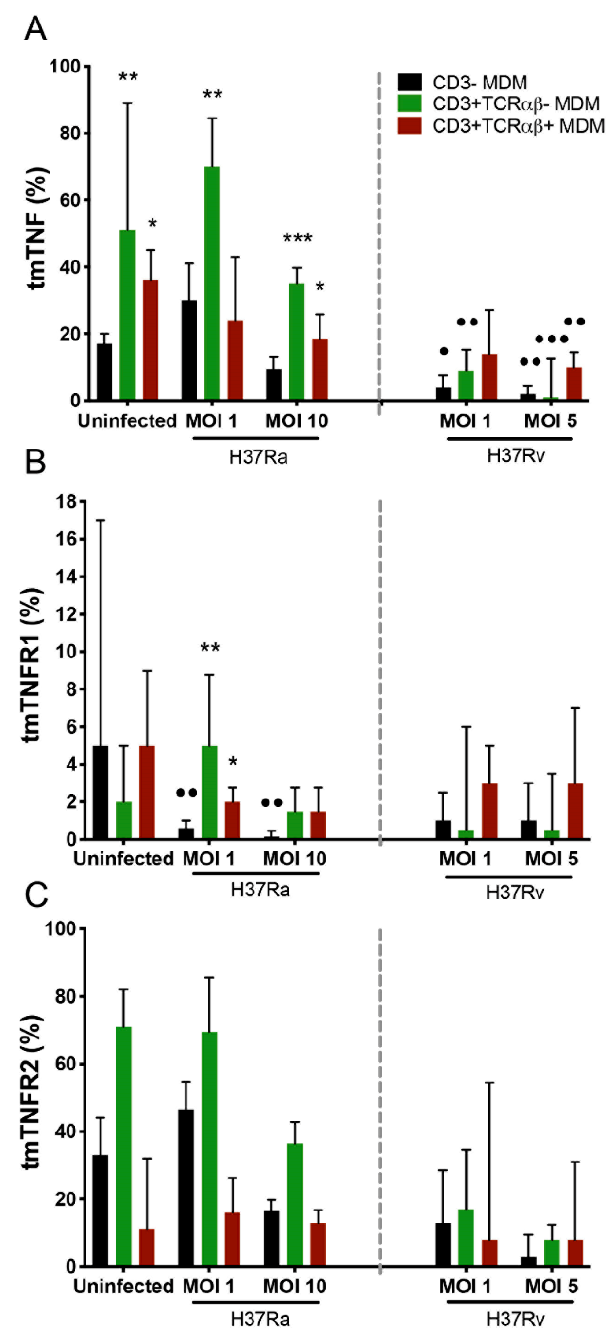
Figure 3. Expression of tmTNF on myocyte-derived macrophages (MDMs) infected with the My- cobacterium tuberculosis (Mtb) H37Rv virulent strain decreased, whereas that of only tmTNFR1 signif- icantly decreased in MDMs infected with the Mtb H37Ra avirulent strain. After 7 days in culture, 2 × 10 6 MDMs (per condition) were administered, and at 24 h post-infection, they were recovered for flow cytometric analysis. Frequency of Mtb-infected MDM subpopulations expressing tmTNF ( A ), tmTNFR1 ( B ), and tmTNFR2 ( C ) molecules. Bar graphs show median values and interquartile ranges (IQRs, 10–90) from four independent experiments. Kruskal–Wallis tests followed by Dunn’s post-tests were performed to compare macrophage subpopulations under the same MOI conditions versus the CD3 − MDM subpopulation, * p < 0.05, ** p < 0.01, *** p < 0.001, and, to compare the infected macrophage subpopulation versus its counterpart under uninfected conditions, • p < 0.05, •• p <